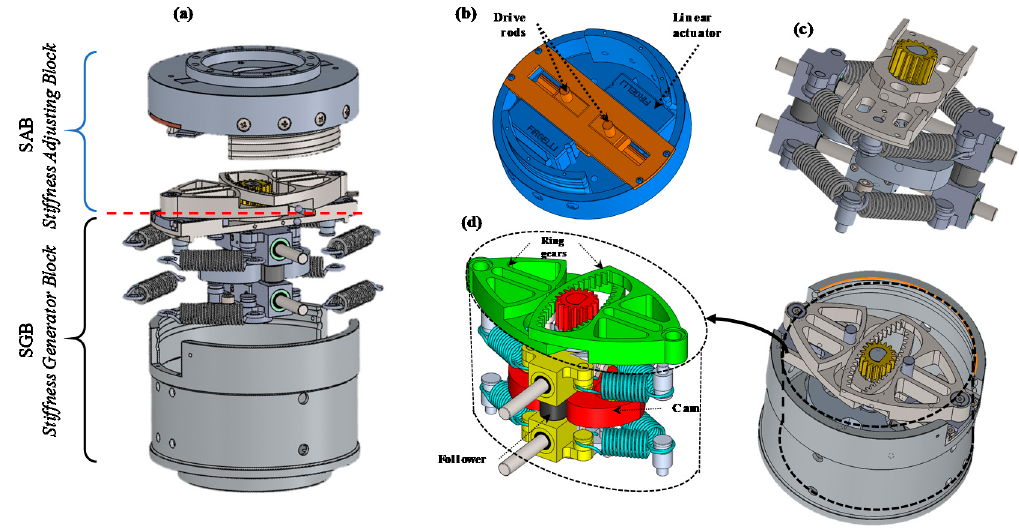
Figure 6. The V2SOM prototype ( a ) Exploded view of V2SOM ( b ) CAD model of SAB ( c ) CAD model of the cam follower mechanism with springs ( d ) CAD model of SGB.